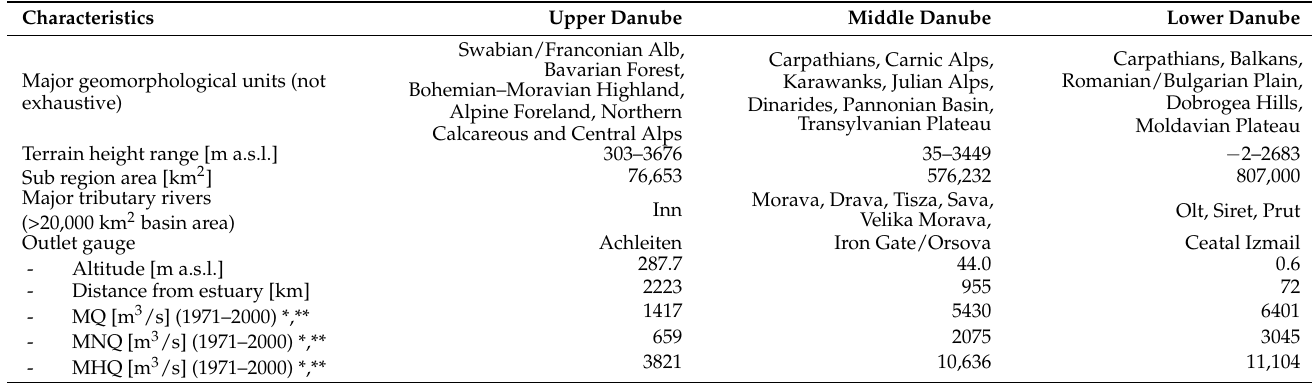
Table 1. Main morphological and hydrographic characteristics of the Upper, Middle and Lower Danube (data sources: Schiller et al. [26], Regionale Zusammenarbeit der Donauländer (RZD) [35], Farr et al. [27] and Global Runoff Data Centre (GRDC)